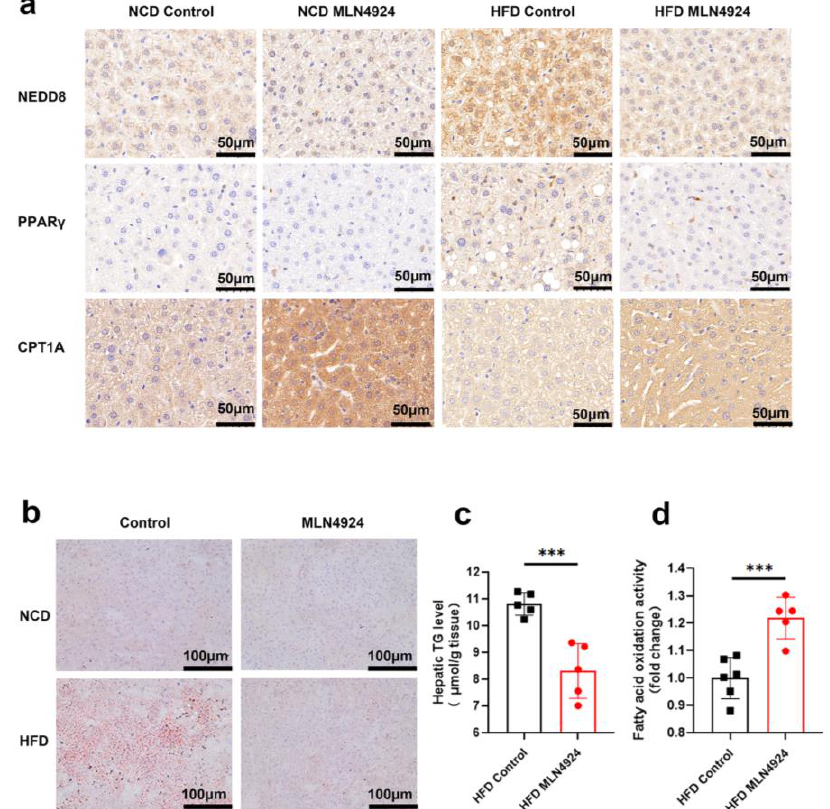
Figure 6. MLN4924 can regulate lipid metabolism in liver by increasing fatty acid oxidation and decreasing the triglycerides accumulation. ( a ) Representative immunohistochemical staining pictures of liver sections from NCD-fed and HFD-fed male mice treated with or without MLN4924 showed the expressions of NEDD8, PPARγ and CPT1A. ( b ) Representative images of ORO staining liver tissues in indicated mice were presented. ( c ) Hepatic triglyceride contents in HFD-fed mice were measured ( n = 5 per group). ( d ) Mitochondria fatty acid oxidation fluxes in HFD-fed mice were measured ( n =5–6 per group). Data represents the mean ± SD, n ≥ 3. A two-tailed Student’s t test was used for statistical analysis (*** p < 0.001).